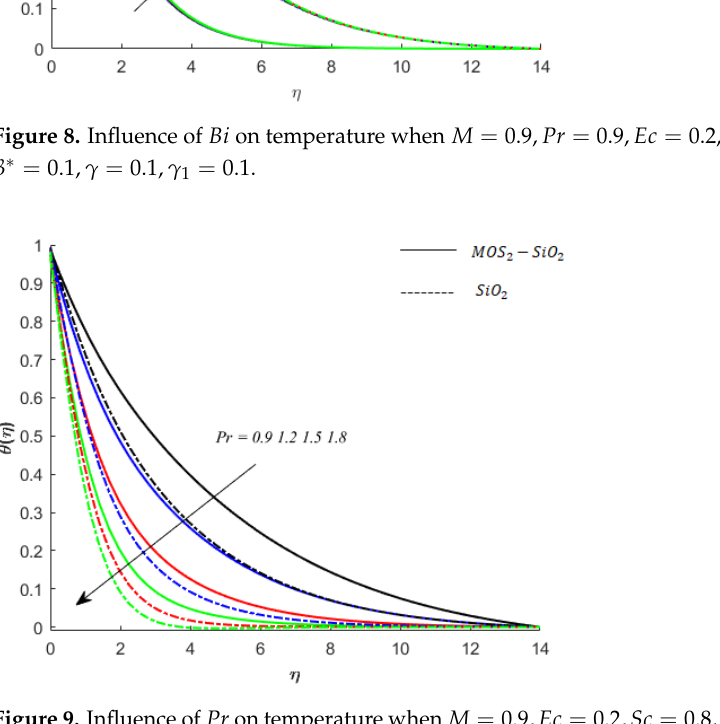
Figure 9. Influence of 𝑃𝑟 on temperature when 𝑀 = 0.9, 𝐸𝑐 = 0.2, 𝑆𝑐 = 0.8, 𝐾 = 0.1, 𝐸𝑖 = 0.1, 𝐵𝑖 = 0.05, 𝛽 ∗ = 0.1, 𝛾 = 0.1, 𝛾 (cid:2869) = 0.1 . Temperature of fluid particles and thermal memory effects: The parameter 𝛾 is called the thermal relaxation parameter and has an analogy with the Deborah number proposed for viscoelastic fluid. This parameter determines the restoring characteristics of thermal equilibrium. It is important to mention here for 𝛾 = 0, the non-Fourier’s law re- duces to the classical Fourier’s law, and an increase of 𝛾 replicates the increase in ability of fluid to restore thermal equilibrium. Therefore, the temperature of fluid decreases (see Figure 10).